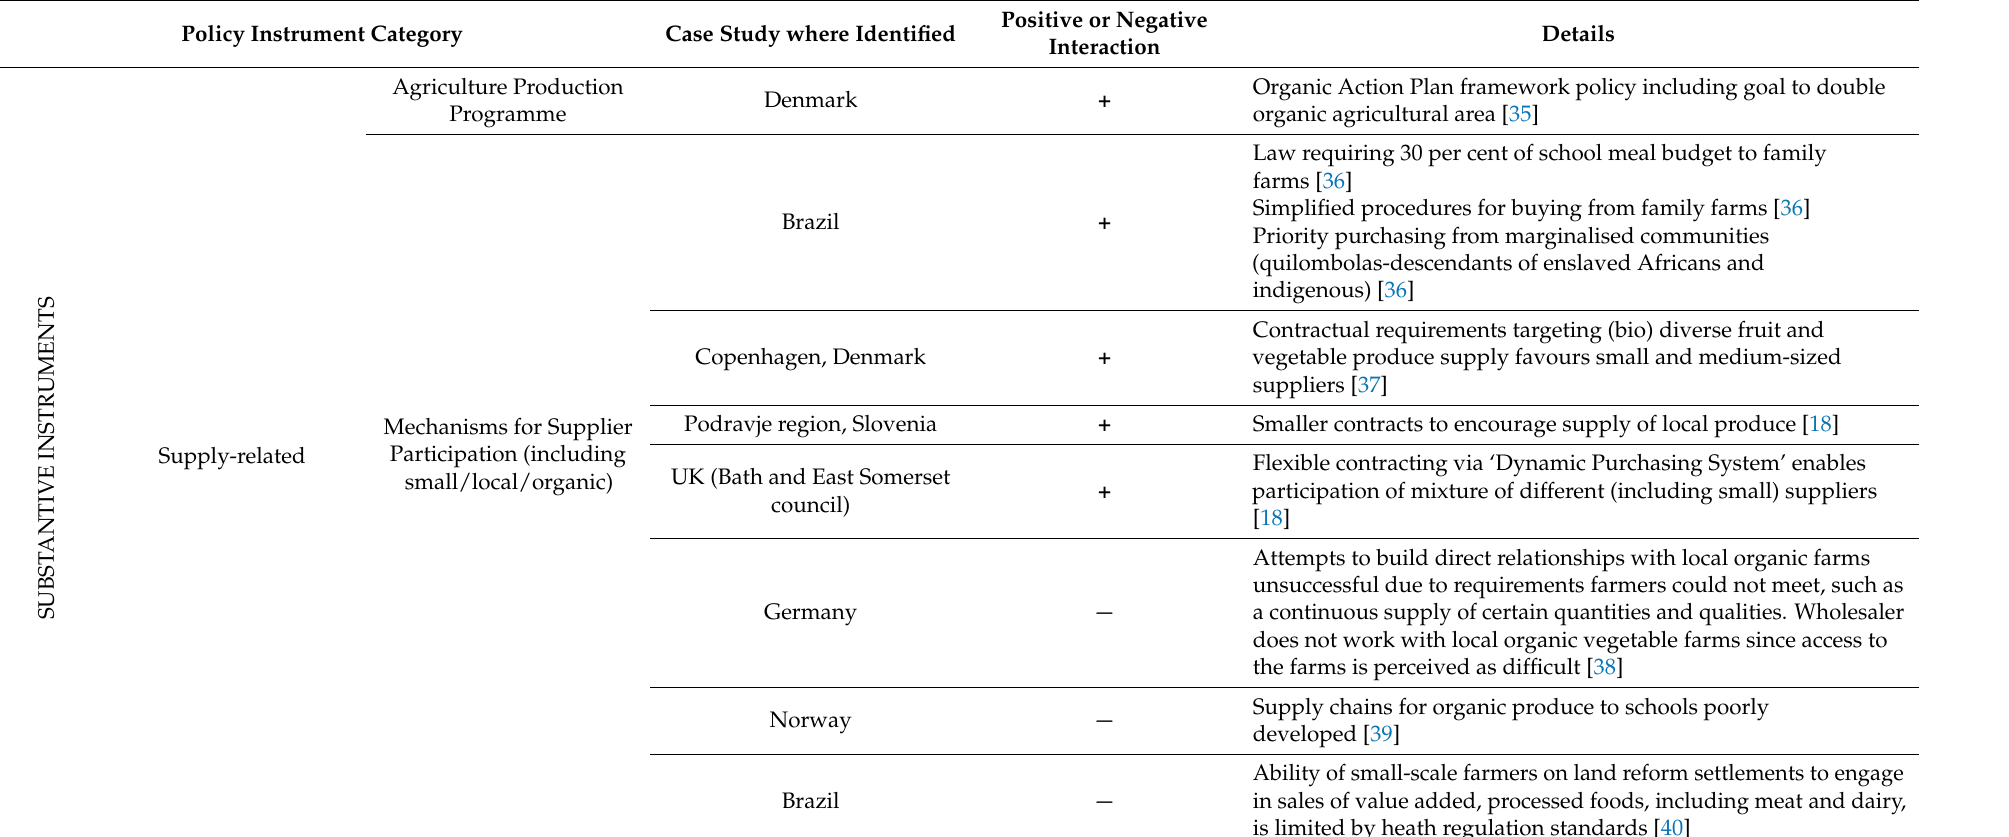
Table 1. Identified policy instrument interactions for public procurement of sustainable